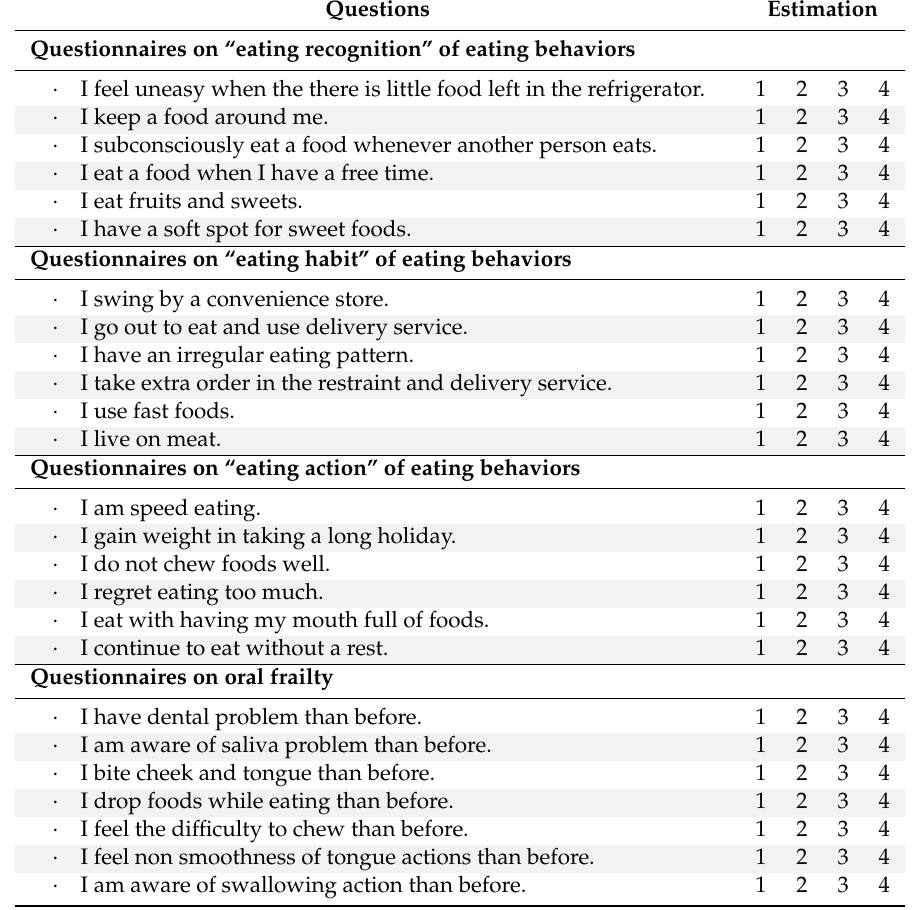
Table 1. Questionnaire of symptoms of eating behaviors and oral frailty.